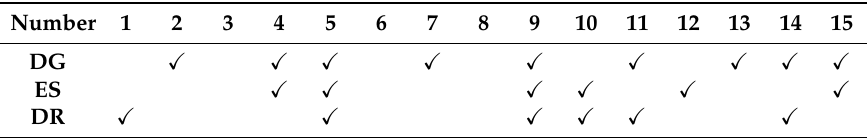
Table 3. Final construction scheme.